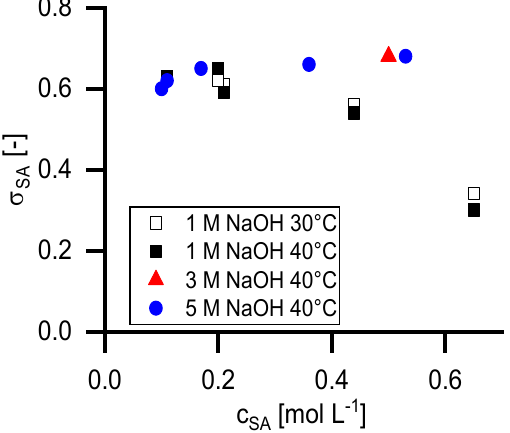
Figure 6. Reflection coefficients of succinic acid in dependency of feed concentration according the Spiegler and Kedem model.